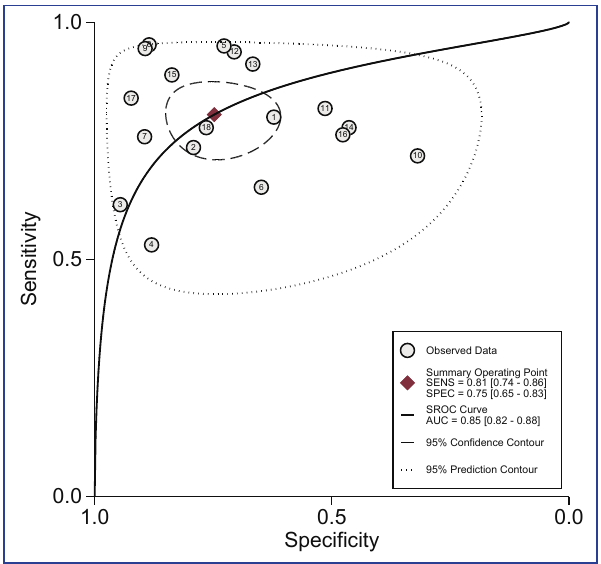
WuRegolistiMartyGuinotBossardWiersemaBoddiMartyFerréHertzbergWybraniecFuDarmonLerolle Figure 2 Forest plot of the sensitivity and specificity of RRI for predicting AKI in critically ill patients. The pooled sensitivity and specificity were 0.81 (95% CI 0.74–0.86) and 0.75 (95% CI 0.65–0.83), respectively Figure 3 SROC graph for the included studies. The AUC of RRI for predicting AKI was 0.85 (95% CI